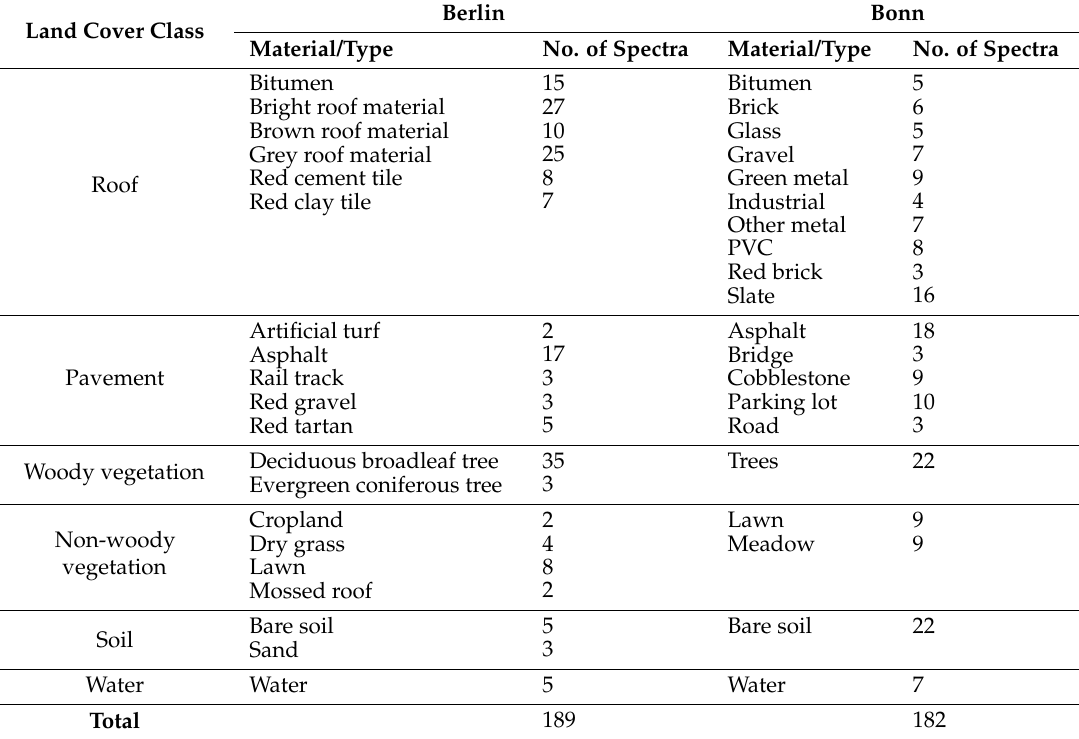
Table 2. Berlin and Bonn spectral libraries organized per land cover class, including an indication of library size per urban material and vegetation